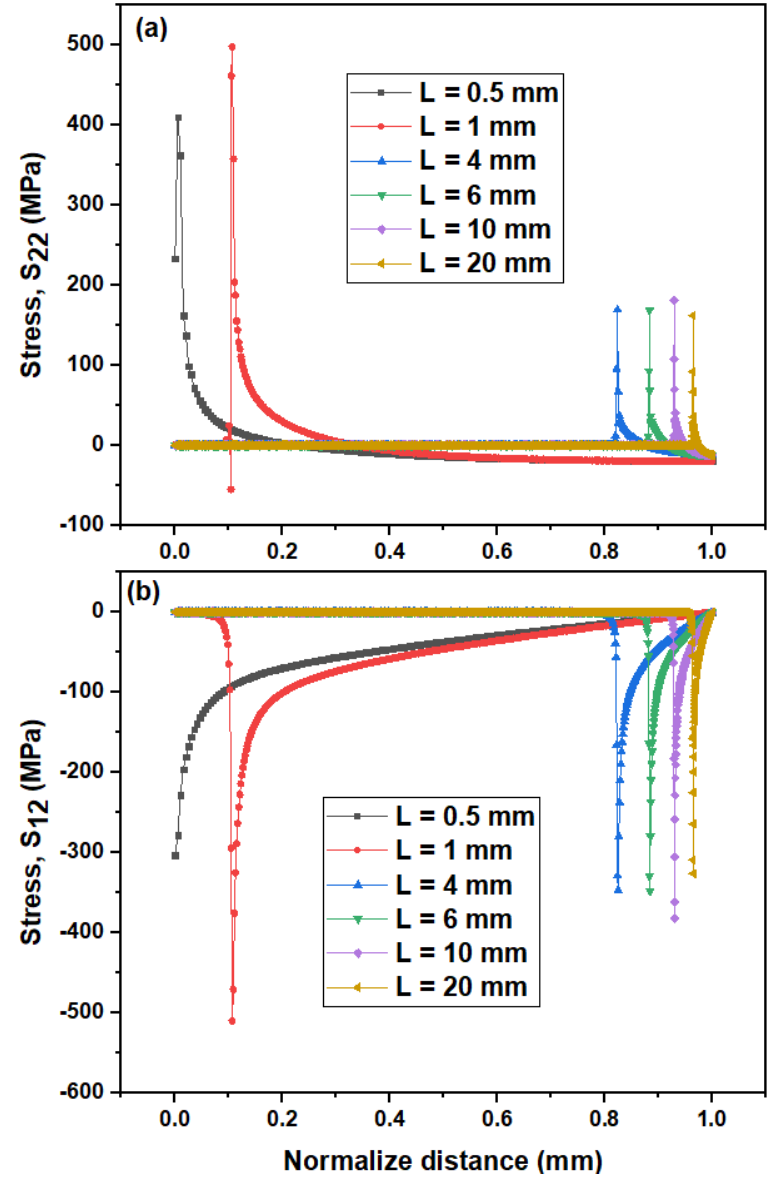
Figure 8. The crack behavior under different L due to stress distribution ( a ) S 22 and ( b ) S 12 . Figure 9 represents the variation of crack length in the ceramic top-coat with the SVC. The SVC has influenced the growth of the crack. At very small SVC, such as L = 0.5 mm, the crack is not extended. With the increase of the SVC, the growth of the crack is continuously increased. To understand the overall damage of coating, the normalized crack length is used, which is the total length of the crack and the model’s length ratio, i.e., a = a / L [57]. The crack is propagated rapidly into the model toward the left, due to a continuously increasing stress on the crack tip as the space between two vertical cracks increases. The spallation of the coating is due to the coalescence of the crack, and this coalescence of the crack is responsible for the TBC’s failure. The crack growth can be decreased by decreasing the SVC, and may extend the lifetime of